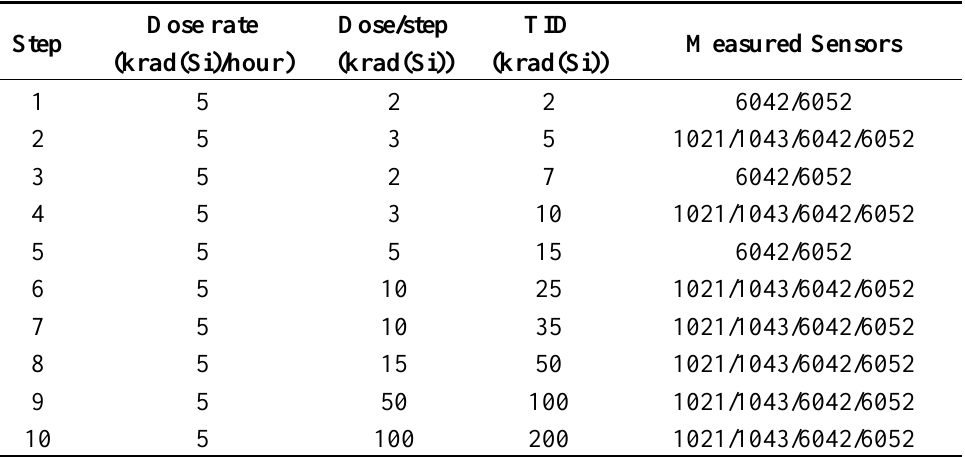
Table 2. Summary of the irradiation test